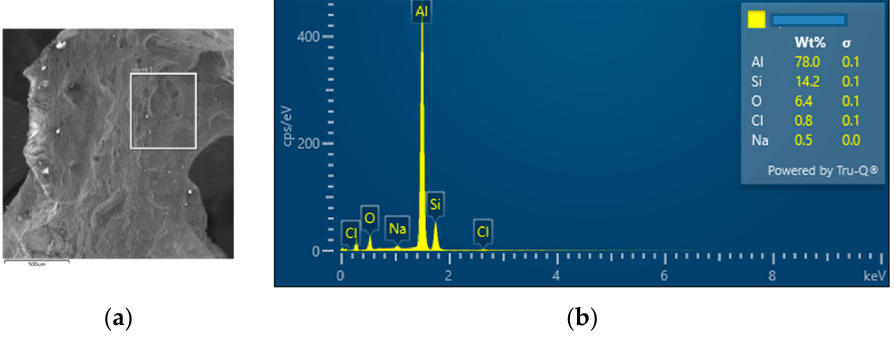
Figure 16. EDX analysis and its evaluation with respect to the local chemical composition: ( a ) chemical composition of the AlSi12 alloy used; ( b ) sample SAM5.